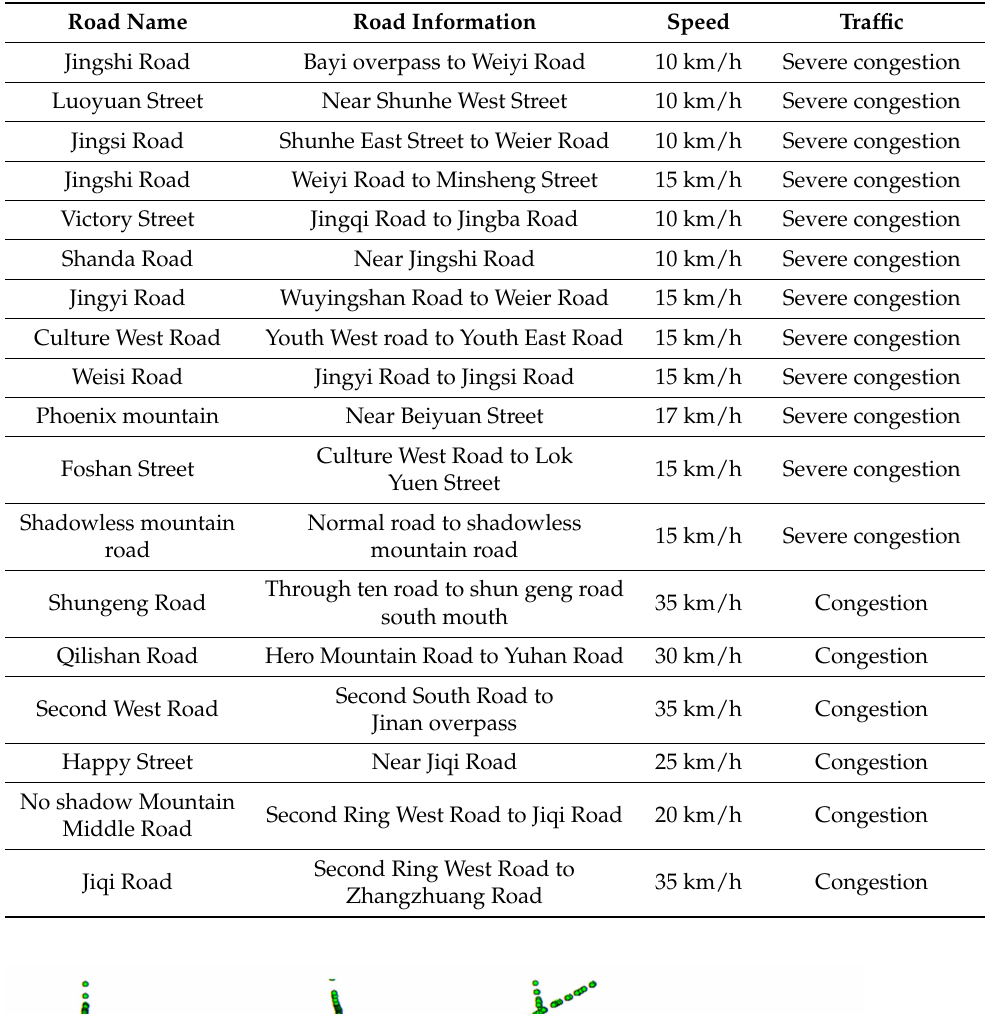
Table 6. Data on major road junctions during morning rush hour.